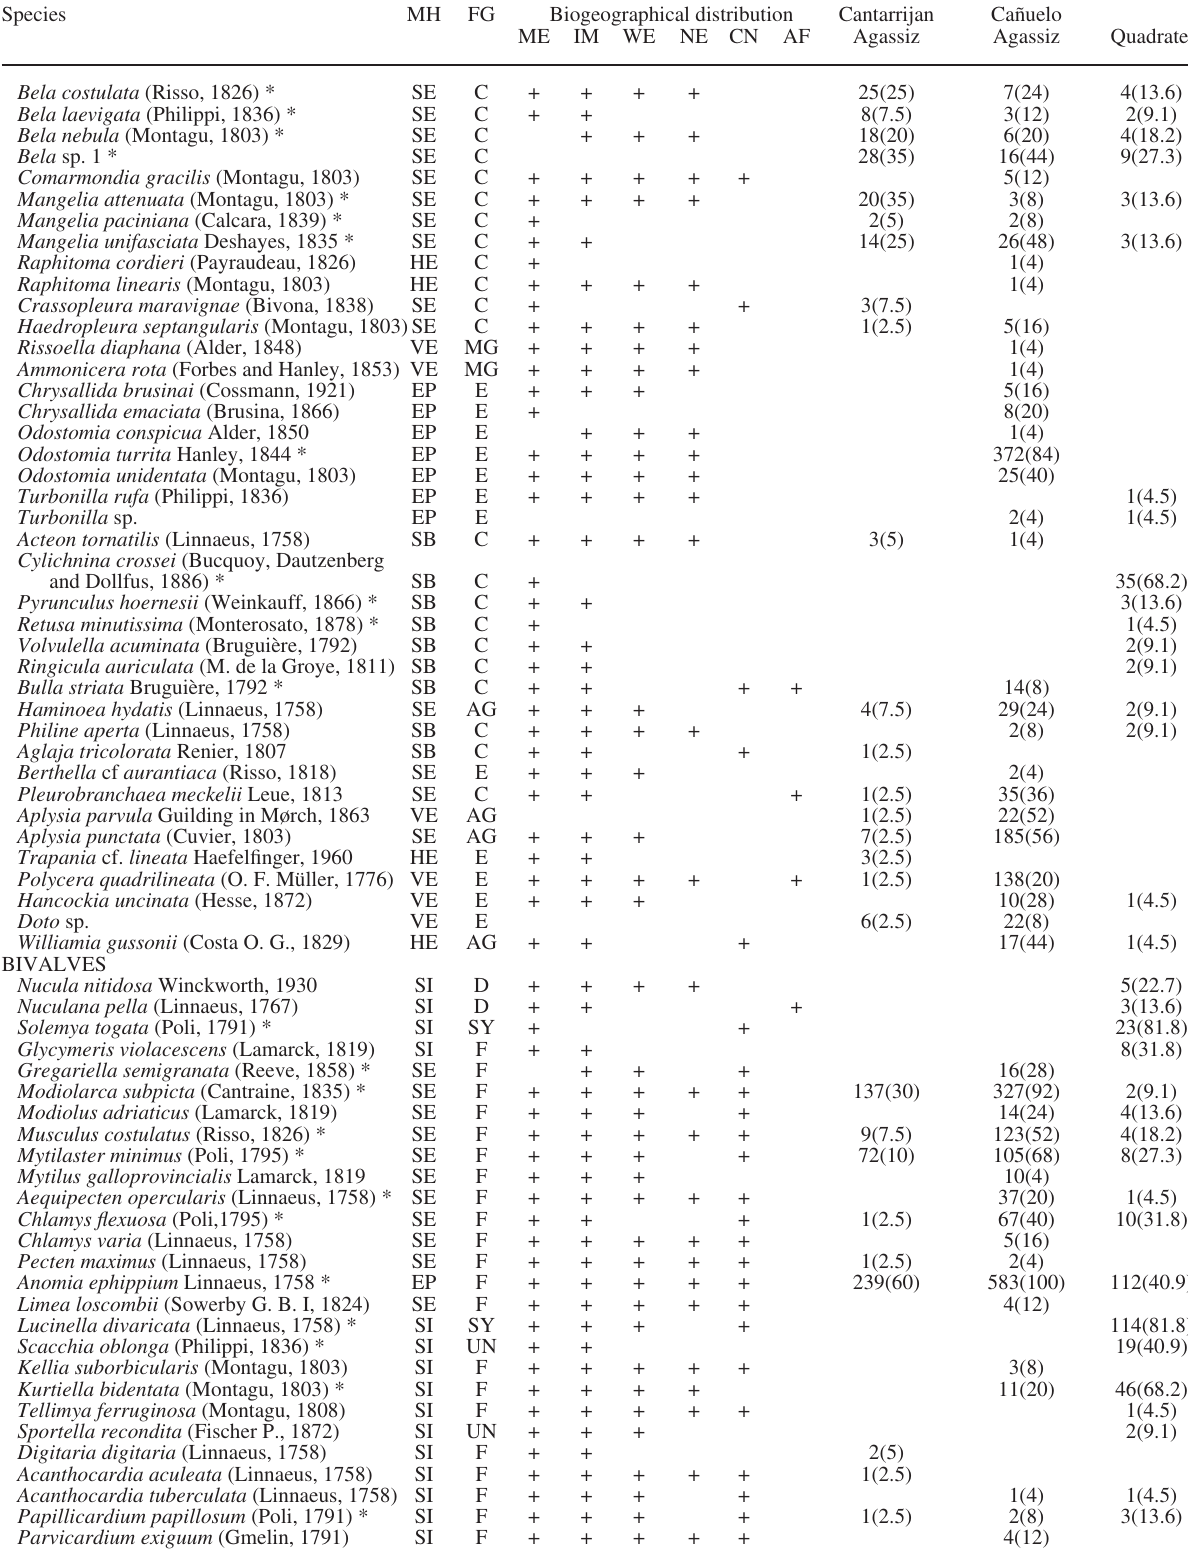
Table 2 (cont.). – faunistic list of molluscs found in Zostera marina beds in southern spain, with quantitative data from arroyo et al. (2006) (Cantarriján, agassiz), Rueda et al. (2008b) (Cañuelo, agassiz) and Rueda and salas (2008) (Cañuelo,